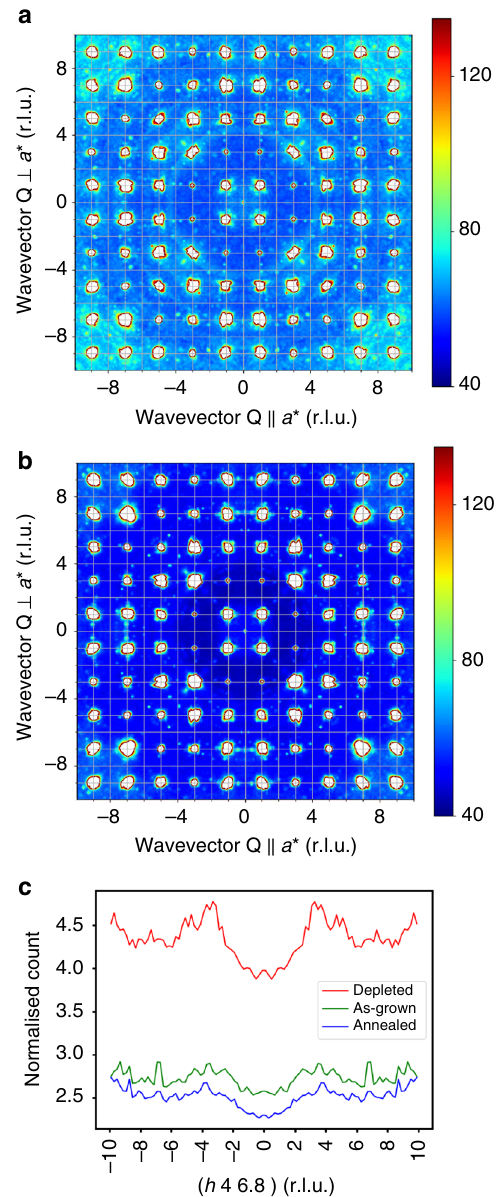
Fig. 2 Structural diffuse scattering in nominally stoichiometric Yb 2 Ti 2 O 7 . a The diffuse neutron scattering from the as-grown, nominally stoichiometric sample measured at T ~ 30 K in the ( hk 7) plane contains weaker structural scattering resembling the scattering from the oxygen- de fi cient sample. b The same crystal measured after annealing in oxygen, showing that most of the diffuse scattering has been eliminated. The remaining scattering is attributed to inelastic scattering from phonons, see Supplementary Figure 1. c 1D cuts along [ h ,4,6.8] for the oxygen-depleted, as-grown and oxygen-annealed samples. This cut was chosen to minimise inelastic scattering. The broad structural diffuse features at h ~ ±4 are clearly present for the oxygen-depleted and as-grown samples, but are greatly reduced for the oxygen-annealed